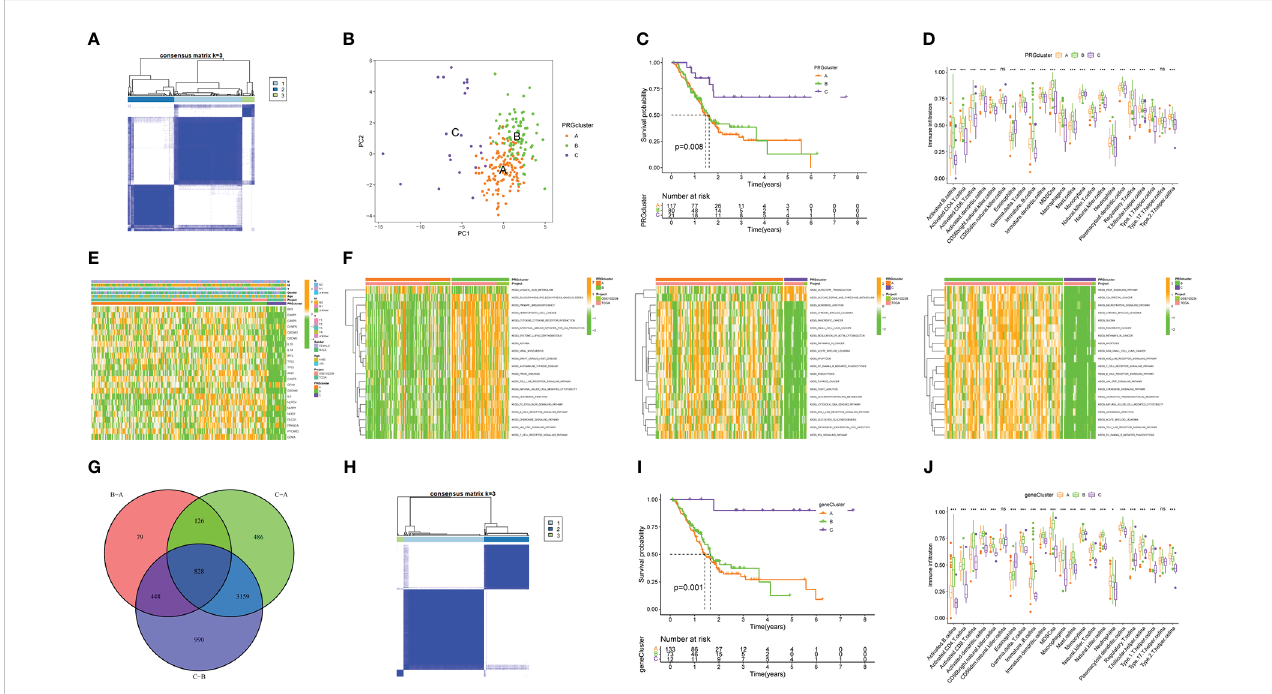
FIGURE 3 Molecular subtypes based on the expression of 23 PRGs and identi fi cation of DEGs. (A) 227 PAAD samples were divided into three PRGclusters using the Euclidean algorithm. (B) Principal component analysis (PCA) among three PRGclusters. (C) Kaplan-Meier survival analysis among three PRGclusters. (D) Comparison of immune cell in fi ltration abundance among three PRGclusters through ssGSEA analysis. (E) Heatmap showing clinicopathological information of three PRGclusters. (F) GSVA analyses of any two PRGclusters. (G) The Venn map of 828 differentially expressed genes (DEGs). (H) A sample of 276 DEGs associated with prognosis was divided into three geneClusters using the Euclidean algorithm. (I) Kaplan-Meier survival analysis among three geneClusters. (J) Differential expression of PRGs among three geneClusters. * P < 0.05, ** P < 0.01, *** P < 0.001. ns, no statistical